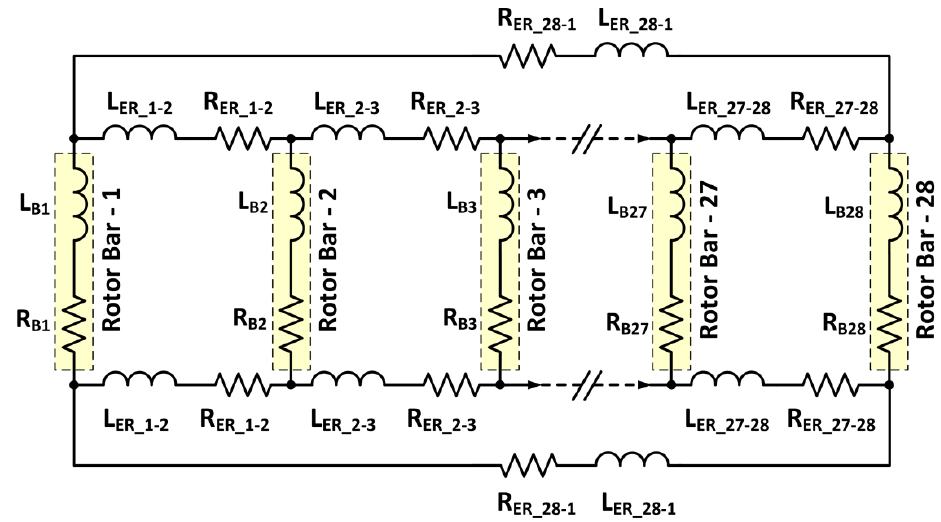
Figure 5. Equivalent electrical circuit of the rotor cage.